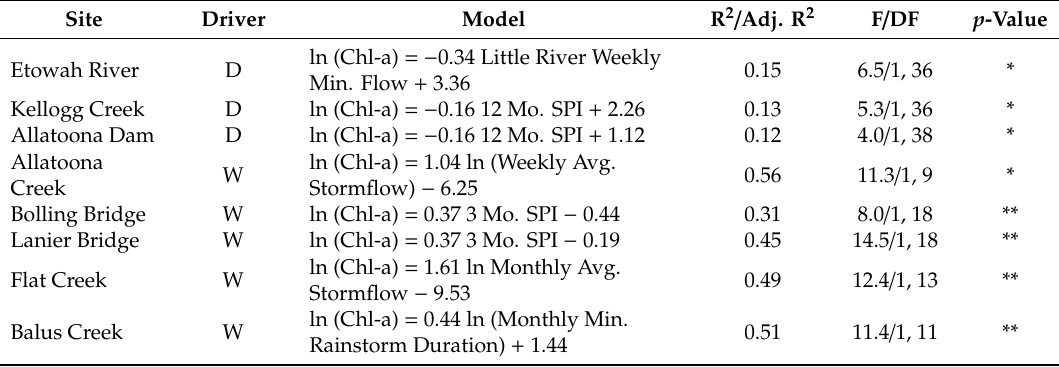
Table 1. Best-Fit Hydrodynamic Regression Models by Site at Lake Allatoona and Lake